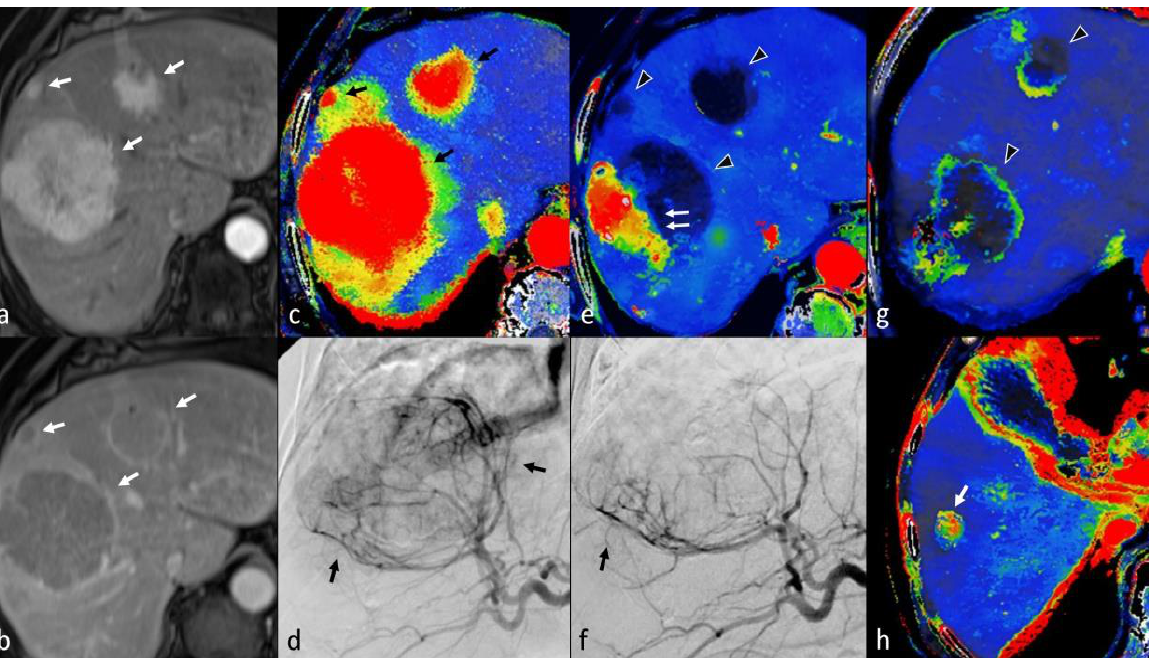
Figure 16. CT Liver perfusion (CTLP) imaging findings before and after transarterial chemoembolization (TACE) of multiple HCC nodules. ( a , b ) T1-w MRI scan of 72-year-old cirrhotic patient on arterial ( a ) and portal phase ( b ) after gadolinium injection showing three liver masses with arterial phase hyperenhancement (arrows in a), wash-out, and capsule (arrows in ( b )) consistent with HCCs. ( c ) Mean slope of increase (MSI) after CTLP confirms MRI findings, showing all hypervascular lesions in red color (black arrows) surrounded by yellow rim, which reflects perfusion